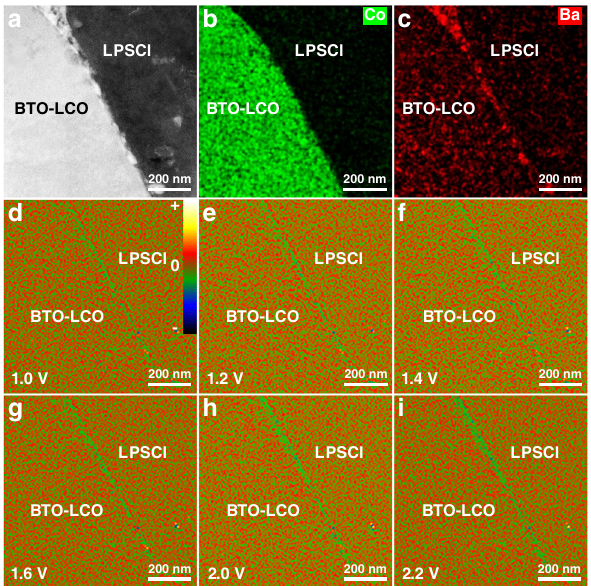
Fig. 4 In situ charge-density-distribution characterization of the BTO – LCO/LPSCl interface. a – c HAADF-STEM image of the BTO – LCO/ LPSCl interface a , and corresponding mappings of Co b and Ba c elements. d – i In situ DPC-STEM observations of net-charge-density accumulation at the BTO – LCO/LPSCl interface with bias voltages of 1.0 V d , 1.2 V e , 1.4 V f , 1.6 V g , 2.0 V h , and 2.2 V i . The color bar in d is de fi ned as the relative magnitude of the positive/negative charge lower than that of LCO/In – Li ( ≈ 2993 Ω ), demonstrating that the BTO nanoparticles effectively restrain the SCL formation.